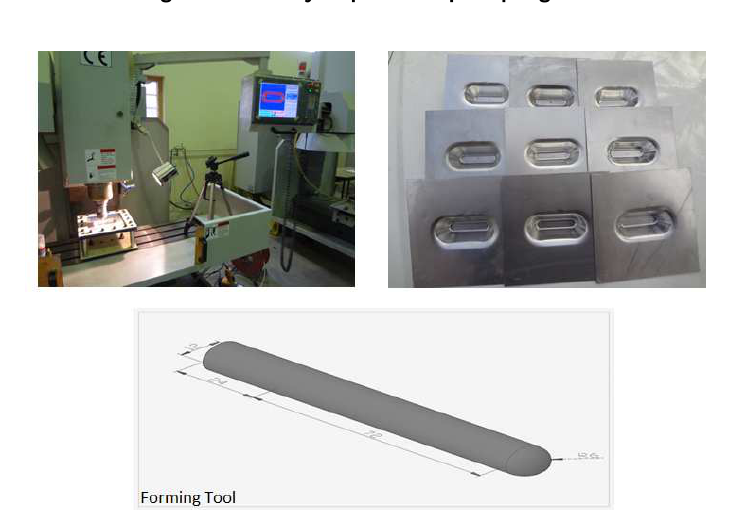
Fig. 3. The experimental setup and nine-samples